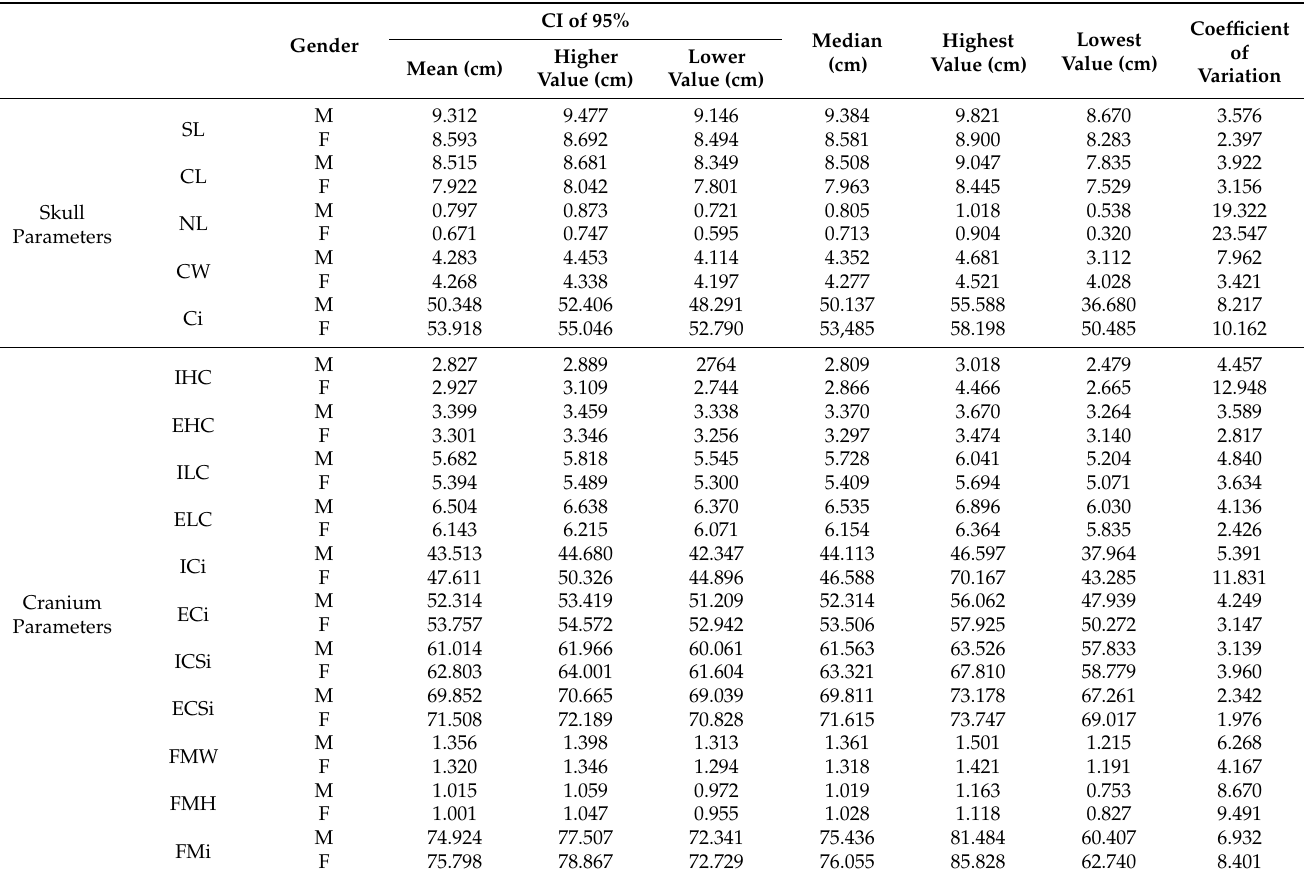
Table 2. Results of the descriptive statistics analysis of the morphometric parameters of the skull and cranium obtained in the population of European shorthair cats relating to